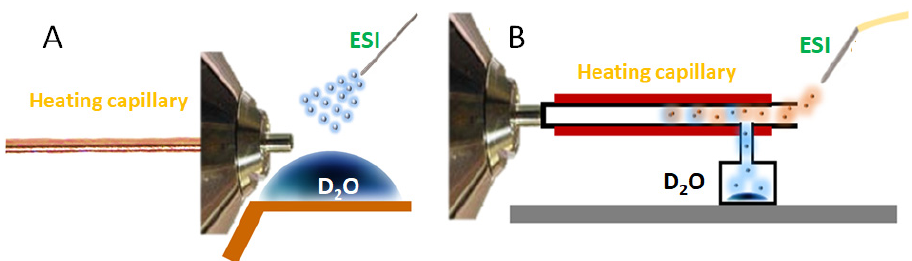
Figure 6. The configuration of the ion sources for performing H/D exchange reactions. ( A )Previously used configuration, and ( B )the configuration used in the present paper.